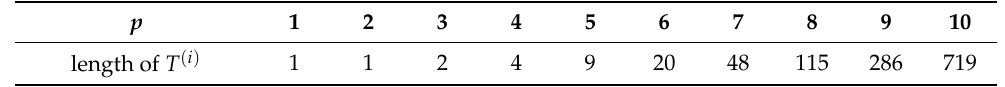
Table 1. Number of order conditions for order p